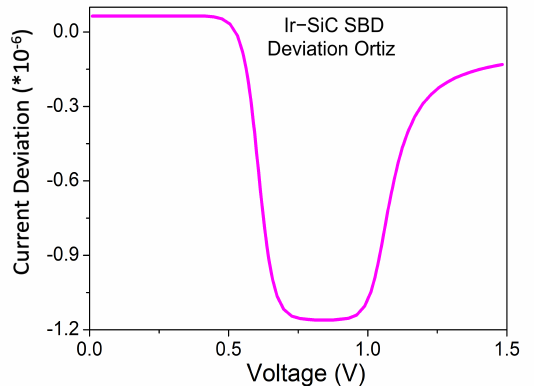
Figure 3. Deviation between experimental data and numerical characteristics obtained via Ortiz– Condé method for the Ir-SiC-based SBD.